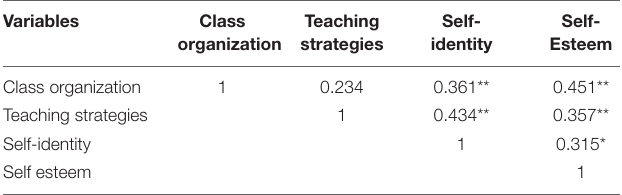
TABLE 1 | Interrelationships between accidental lessons and Students’ self-identity and